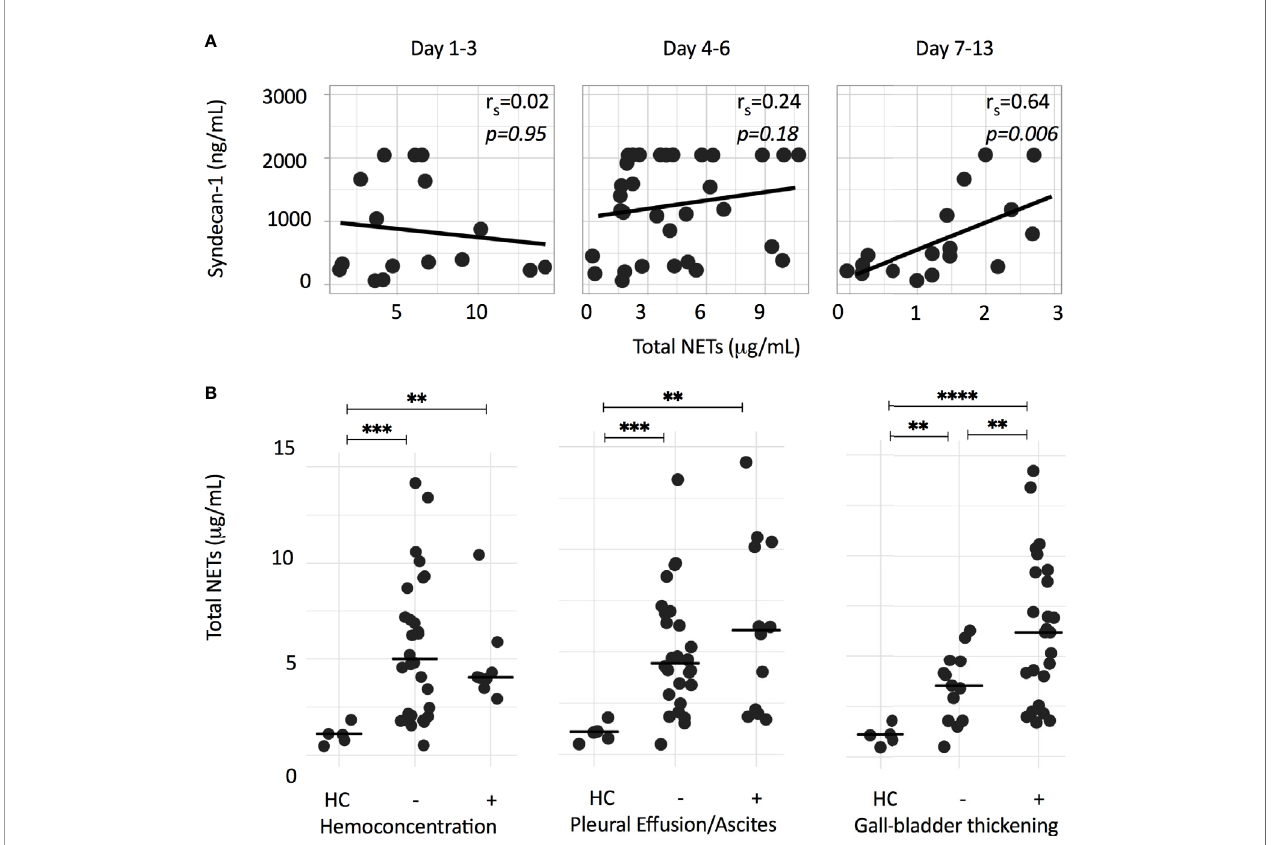
FIGURE 4 | NET formation is associated with syndecan-1, as a surrogate marker for glycocalyx damage, and markers of plasma leakage. (A) Depicted is the Spearman correlation between total NETs ( m g/mL) and plasma syndecan-1 concentrations (ng/mL) at different time points. (B) Total NETs ( m g/mL) of dengue patients from either acute or critical phase were grouped according to the presence of hemoconcentration, pleural effusion/ascites or a thickened (>3 mm) gall bladder wall. Hemoconcentration was de fi ned as an increase in hematocrit of ≥ 20%, or single hematocrit value of >50% for male or >44% for female patients. Differences were assessed using Mann-Whitney U test. **p < 0.01, ***p < 0.001 , ****p < 0.0001 . HC, healthy